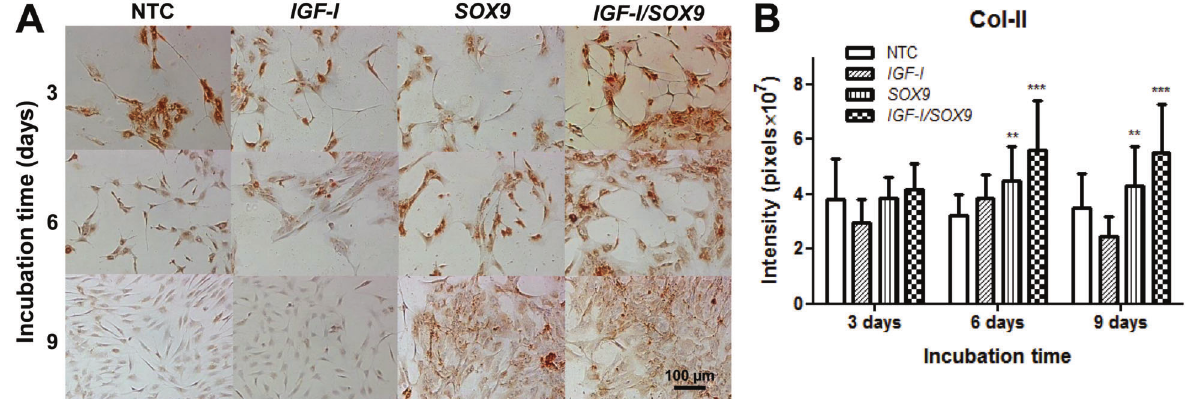
Figure 4. Immunocytochemical detection of Col-II. Speci fi c anti-Col-II primary monoclonal antibodies ( A ) were used to stain the non- transfected human chondrocytes (NTC) and those transfected with plasmids pCMV-SPORT6 IGF-I ( IGF-I ), pCMV-SPORT6 SOX9 ( SOX9 ), or following cotransfection with both plasmids ( IGF-I/SOX9 ). Images were taken on days 3, 6, and 9 post-transfection. Once transfected, the cells were incubated at 37°C in a 5% CO 2 atmosphere. Quanti fi ed in situ densitometry is shown in the bar graph ( B ). Data are reported as the average and standard deviation of the densitometry value normalized to the number of cells in the evaluated area (expressed in pixels (cid:1) 10 7 ), which was performed on all chondrocytes observed in 32 images on days 3, 6, and 9 post-transfection.